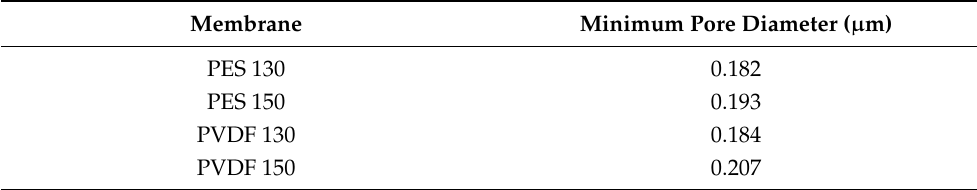
Table 2. Minimum pore diameters of the membranes.